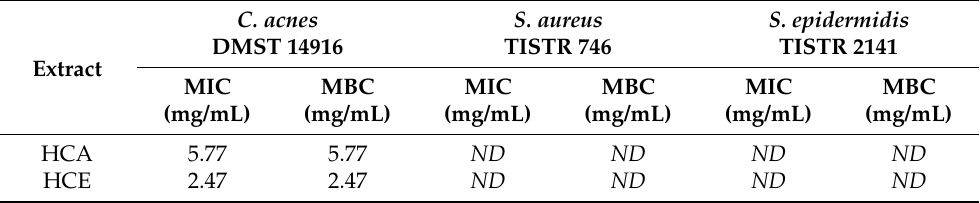
Table 3. Antimicrobial activities of H. cordata extracts against acne-related